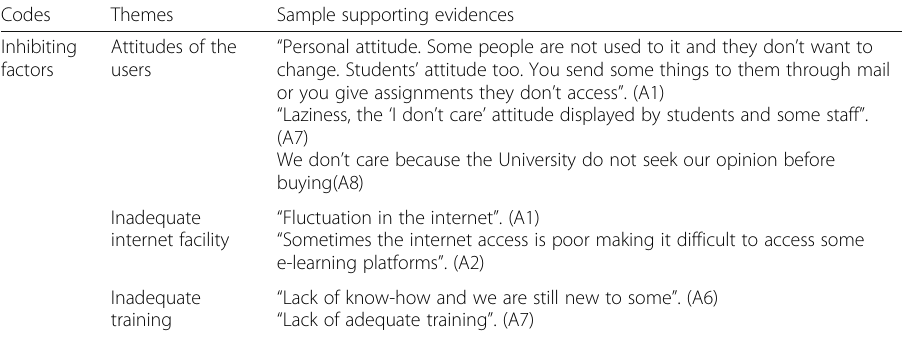
Table 9 Major factors inhibiting the adoption of e-learning facilities